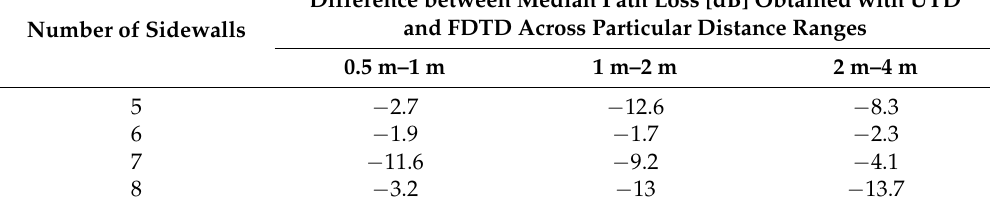
Table 1. Differences between median values for path loss obtained using UTD and FDTD with different numbers of sidewalls approximating the main body cylinder across three distance ranges.